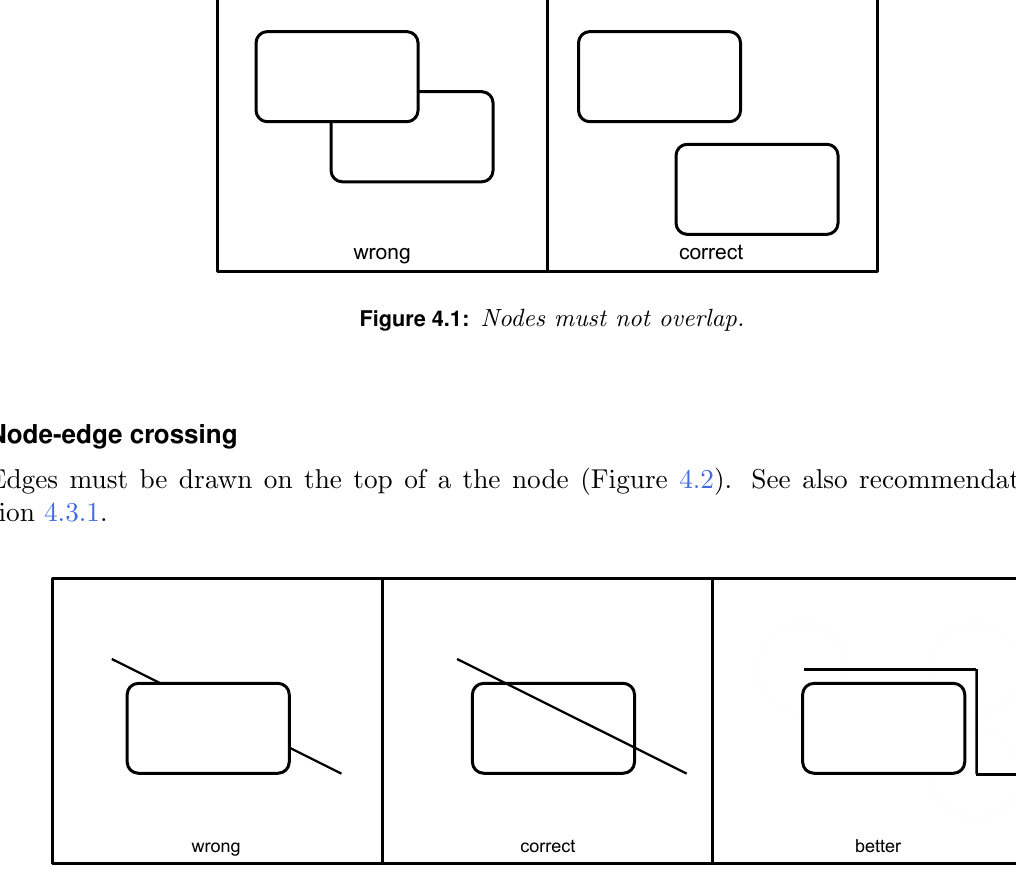
Figure 4.2: If an edge crosses a node, the edge must be drawn on top of the